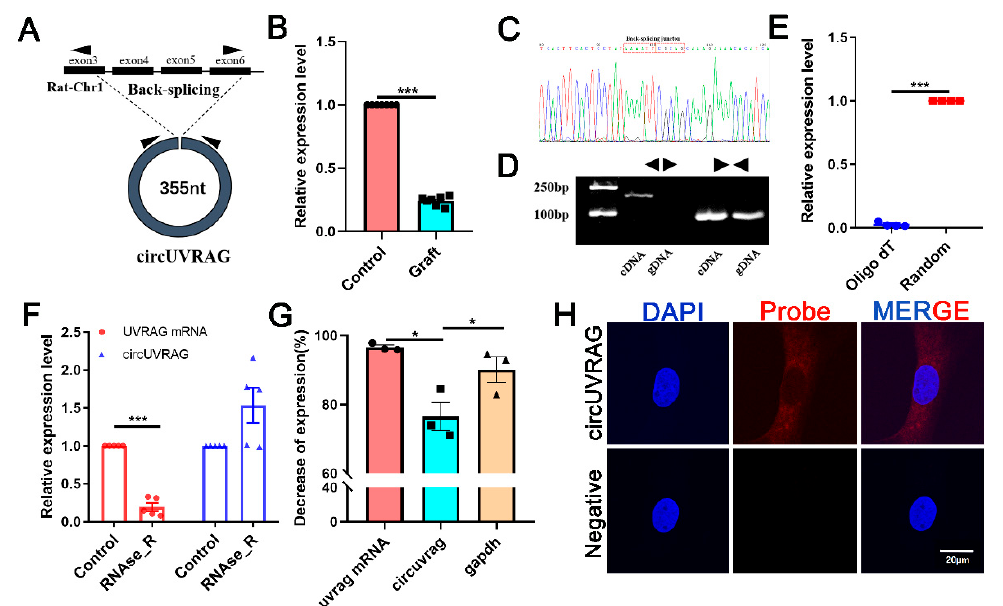
Figure 2. Identification and location of circUVRAG in rat VSMCs. ( A ). Schema shows that circUVRAG is derived from exons 3, 4, 5 and 6 of uvrag . Divergent primers are designed to detect circUVRAG. ( B ). QPCR confirms that circUVRAG is decreased in the graft vein compared to the control ( n = 7). ( C ). Sanger sequencing demonstrates the back-splicing junction of circUVRAG by using divergent primers. ( D ). PCR and agarose gel electrophoresis show that divergent primers amplify circUVRAG in cDNA but not gDNA. ( E ). The amplification efficiency with oligo (dT) primer is much lower than random primer ( n = 4). ( F ). With RNase R treatment, linear UVRAG mRNA is digested and circUVRAG shows higher stability ( n = 5). ( G ). Actinomycin D is utilized to block the transcription of DNA for 24 h. The consumption of circUVRAG is much less than linear UVRAG mRNA and GAPDH ( n = 3). ( H ). Fluorescence in situ hybridization (FISH) assay shows that circUVRAG is mainly located in the cytoplasm of VSMCs. DAPI stains the nucleus blue and red indicates circUVRAG. Bar = 20 µ m, * p < 0.05, *** p < 0.001.